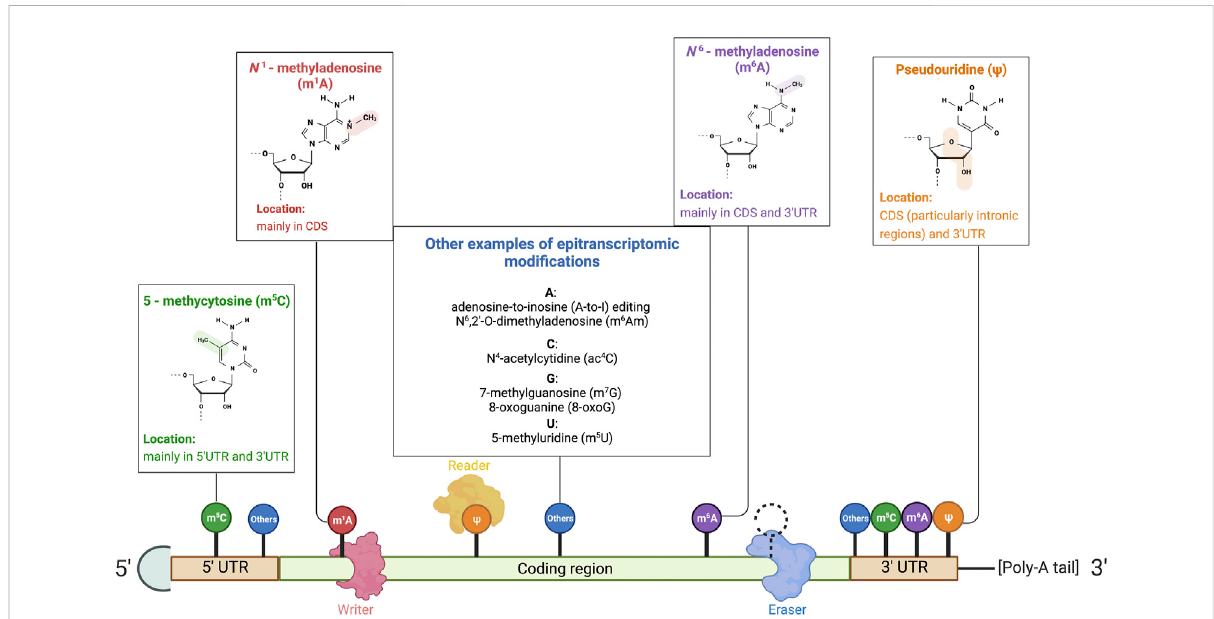
FIGURE 1 Illustration of RNA-modifying proteins on mRNA and common RNA modi fi cations. Common base modi fi cations include N 6 – methyladenosine (m 6 A), N 1 – methyladenosine (m 1 A), pseudouridine ( ψ ), and 5 – methycytosine (m 5 C), to name but a few. Less common modi fi cations are also listed in theillustration.RNA-modifyingproteinsthatgoverntheexpressionofthemRNAtranscriptbymanipulatingepitranscriptomicsitesinclude(1)writers that deposit RNA modi fi cations, (2) erasers that remove the epitranscriptomics modi fi cations, and (3) readers that are recruited and recognize the modi fi cations to alter the fate of transcripts. Reprinted from “ Common eukaryotic mRNA modi fi cations ” , by BioRender.com (2020). Retrieved from